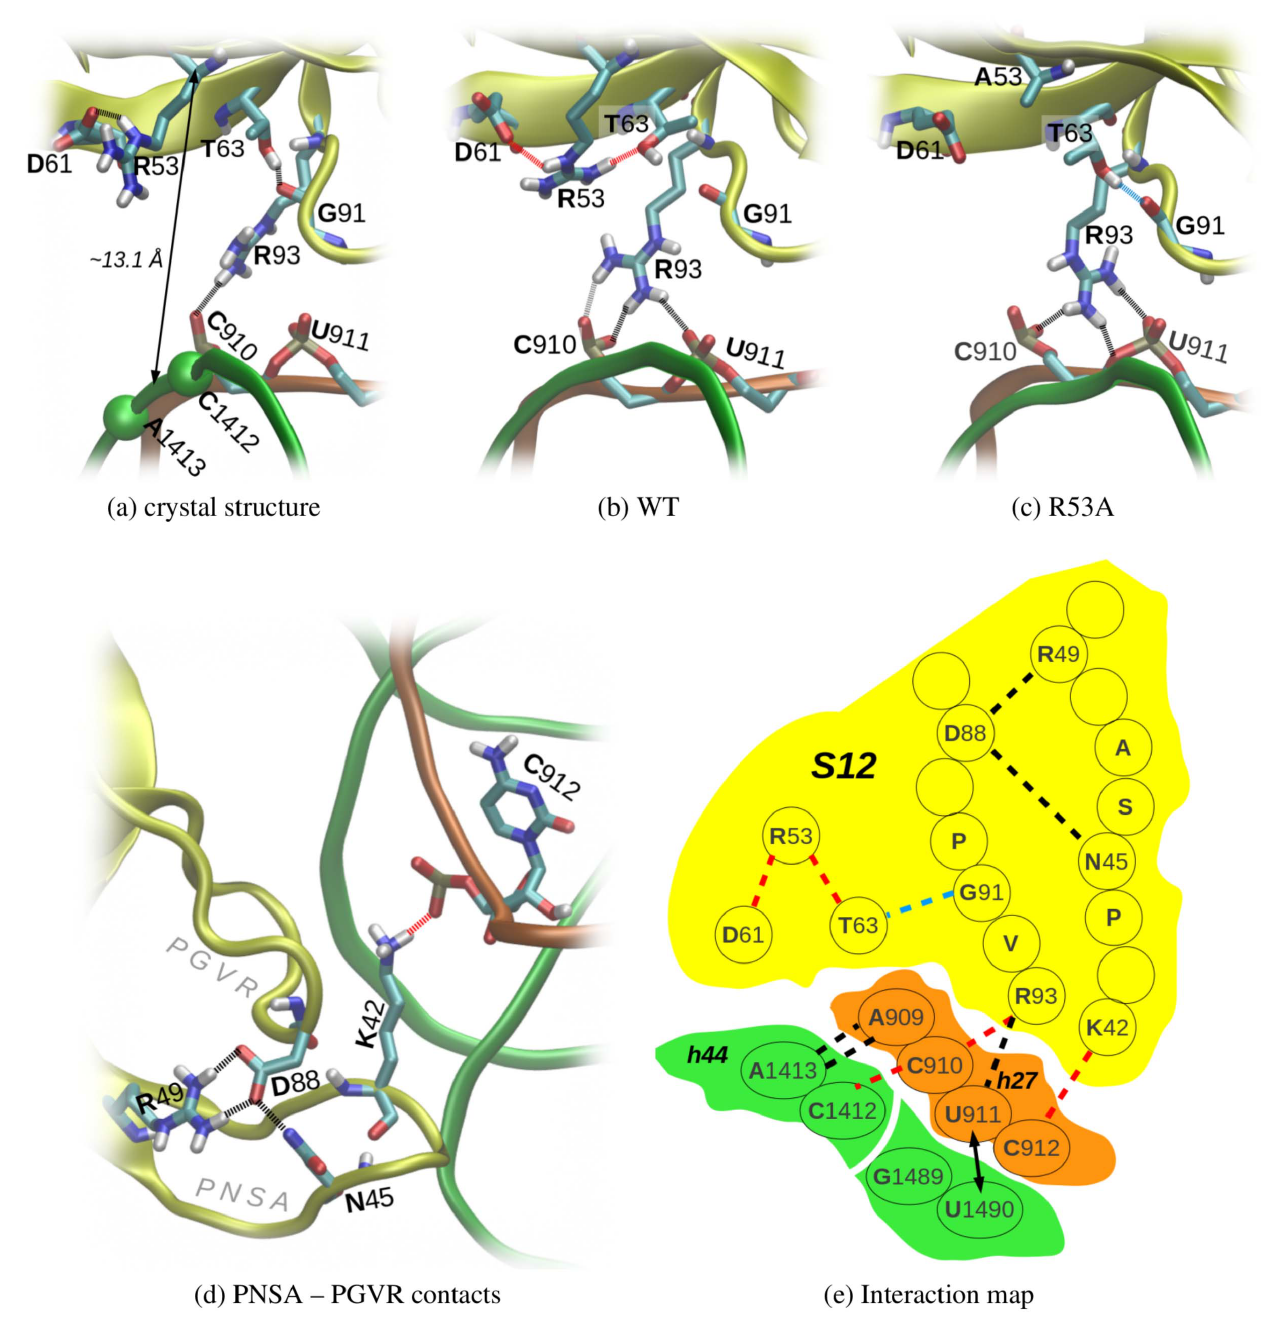
Figure 10. The network of interactions between S12 and rRNA. (a, b, c) Snapshots are shown of the most frequent H-bonds formed between R/A53 or R93 and other regions of the ribosome; only polar hydrogens are shown. Positions of the C 3 0 atoms of C1412 and A1413 are indicated. (d) The stable H-bonds between the PNSA and PGVR loops are shown, as is the most frequent H-bond of K42 (which may affect the mutual position of h27 and h44). e) This schematic interaction map for S12 and rRNA shows S12 (yellow), h44 (green), and h27 (orange). The H-bonds observed in MD simulations are denoted by dashed lines as either stable (black), broken/destabilized in some variants (red) or formed upon S12 mutation (light blue). The close neighboring h27 and h44 residues, near the decoding site, are indicated by a black arrow (see text and Fig 9a).